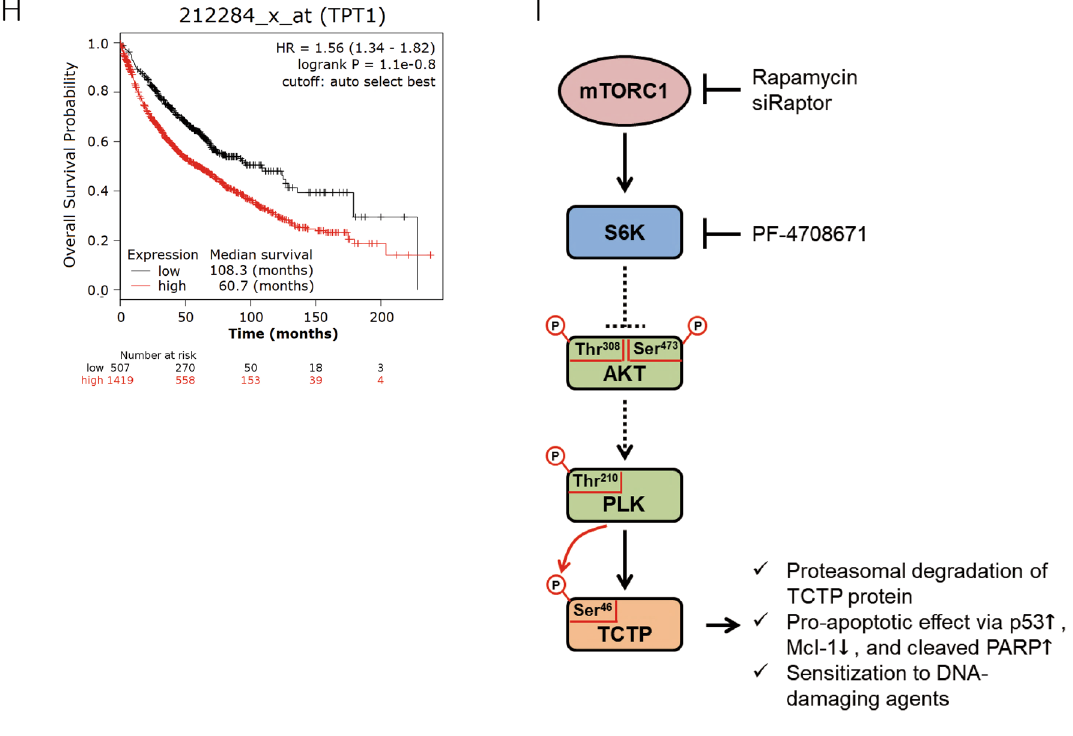
Figure 7. Rapamycin enhances the efficacy of cisplatin in an A549 lung cancer xenograft model through TCTP down-regulation and apoptosis promotion. ( A – G ) A549 cells were inoculated into BALB/c nude mice. After 4 weeks, mice were injected with 1.5 mg/kg cisplatin and/or 1 mg/kg rapamycin twice a week for 6 weeks. The long and short diameters of each tumor and the body weight of the mice were measured twice a week. ( A ) Schematic of the experimental procedure is depicted. ( B , C ) Changes in the within-group average of tumor volume (mm 3 ) at each measurement point and the tumor volumes at the end point are presented as means ± SD. ( D – G ) Using the immunodetection data in Supplementary Fig. S4C, the protein levels of TCTP ( D ), cleaved PARP ( E ), p53 ( F ), and Mcl-1 ( G ) were quantified, normalized to that of GAPDH or total PARP, and are presented as means ± SD. ( H ) Overall survival of lung cancer patients with high TCTP expression was significantly lower compared with that of patients with low TCTP expression ( P = 1.1 × 10 −8 ). Kaplan–Meier curves for overall survival in lung cancer patients according to the expression of TPT1 probe 212284_x_at (n = 1926) were obtained from the databases in Kaplan–Meier plotter (http:// kmplot. com/ analy sis/). The log-rank test was performed using auto select best value as a cutoff. ( I ) The schematic illustrates a novel signaling pathway through which TCTP protein is maintained at a high level in lung cancer cells along with the biochemical, molecular, and biological effects of mTORC1 inhibition through TCTP